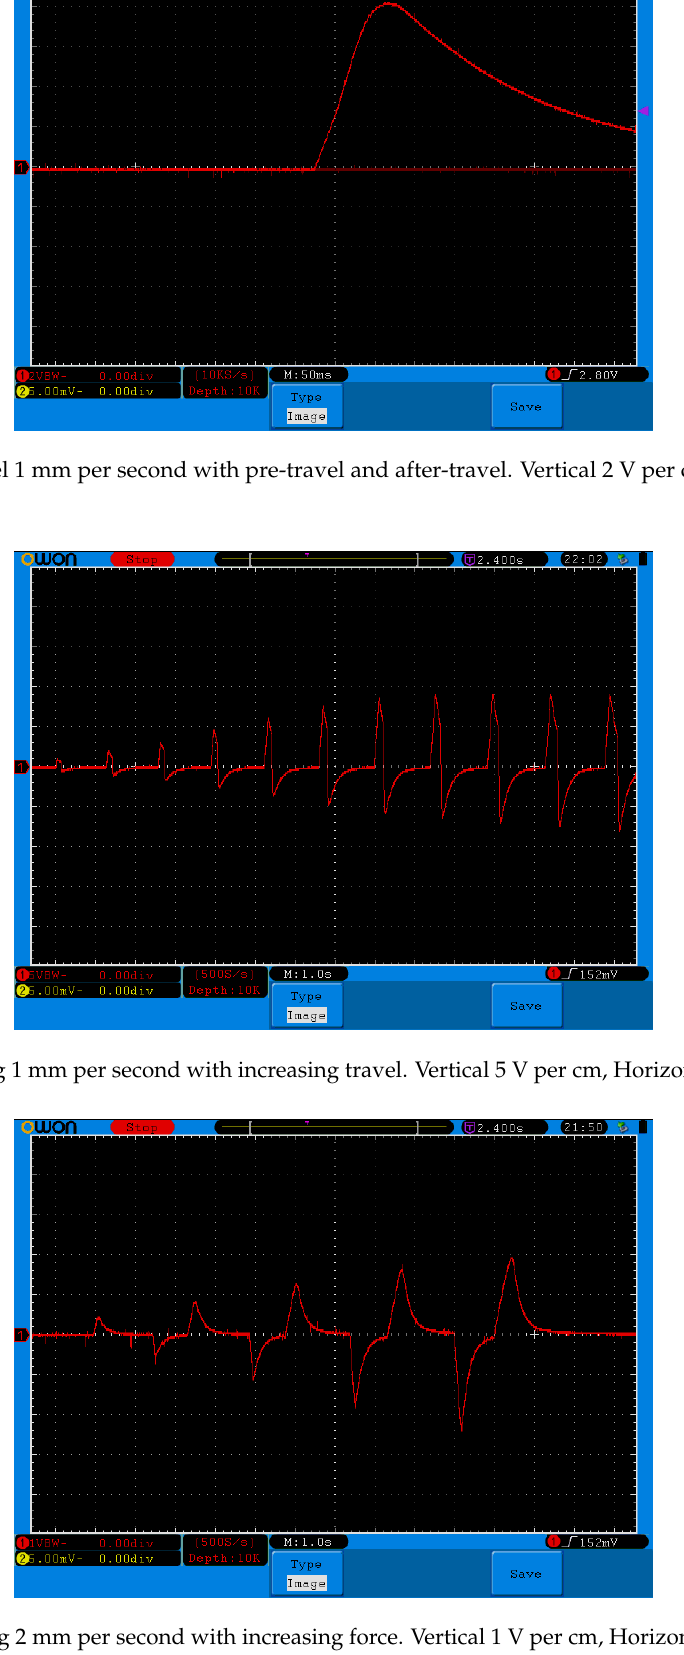
Figure 6. Cycling 2 mm per second with increasing force. Vertical 1 V per cm, Horizontal 1 s per